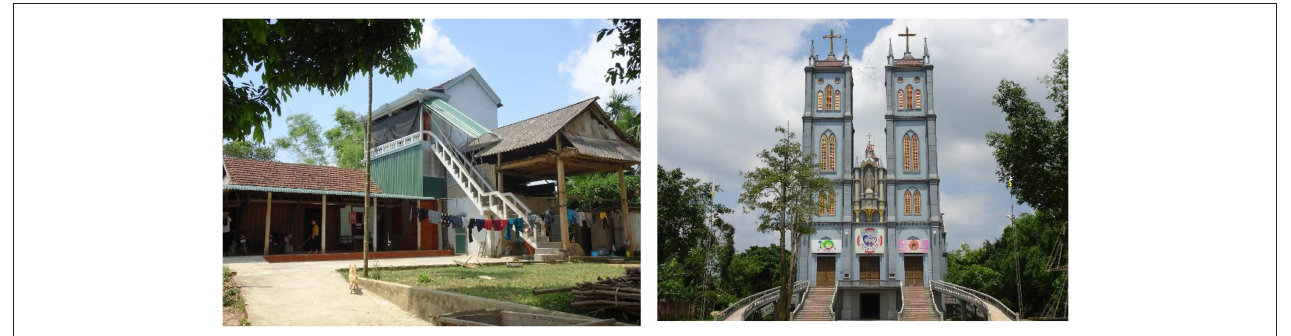
FIGURE 4 | Improved construction practice to cope with the potential floods.